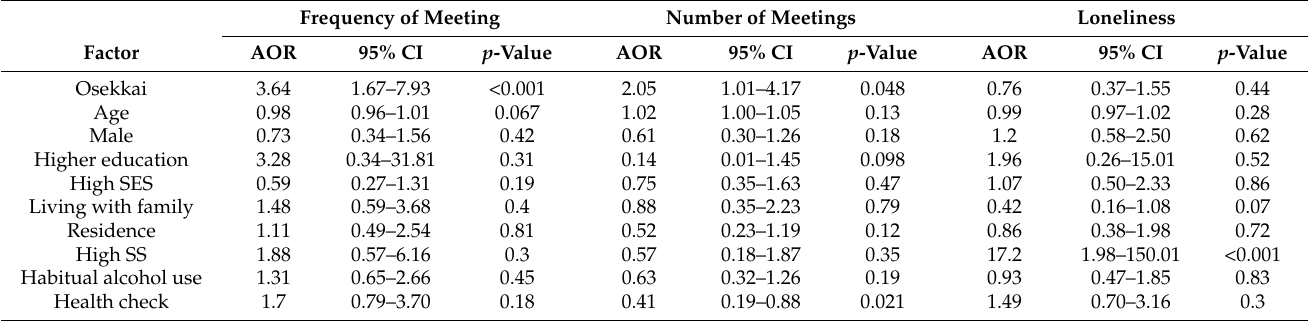
Table 2. Relationship of Osekkai participation with social participation and